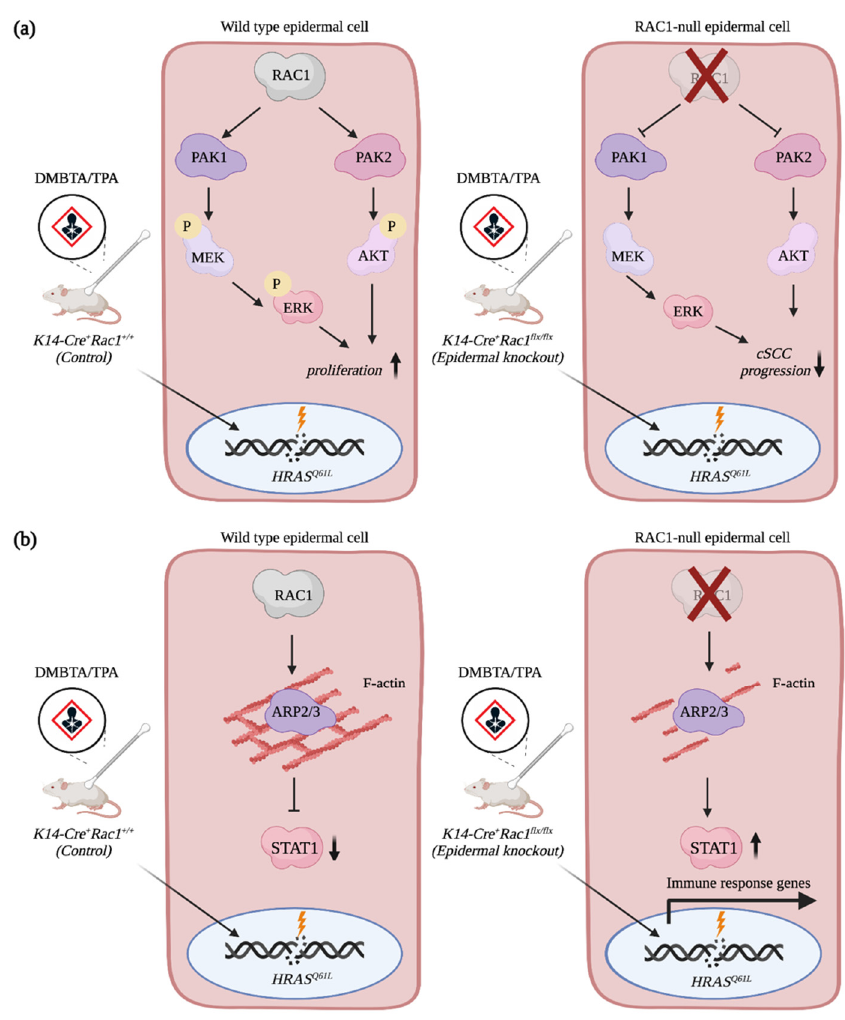
Figure 3. RAC1 contributes to cSCC progression. ( a ) RAC1 promotes hyperproliferation of HRAS Q61L -transformed epidermal cells via AKT and ERK activation. ( b ) RAC1 restricts STAT1 expression in epidermal cells by promoting F-actin assembly. Depletion of Rac1 expression in keratinocytes increases levels of STAT1 and immune response genes, which hypersensitizes keratinocytes to inflammatory stimuli. Created with BioRender.com, accessed on 20 August 2021.